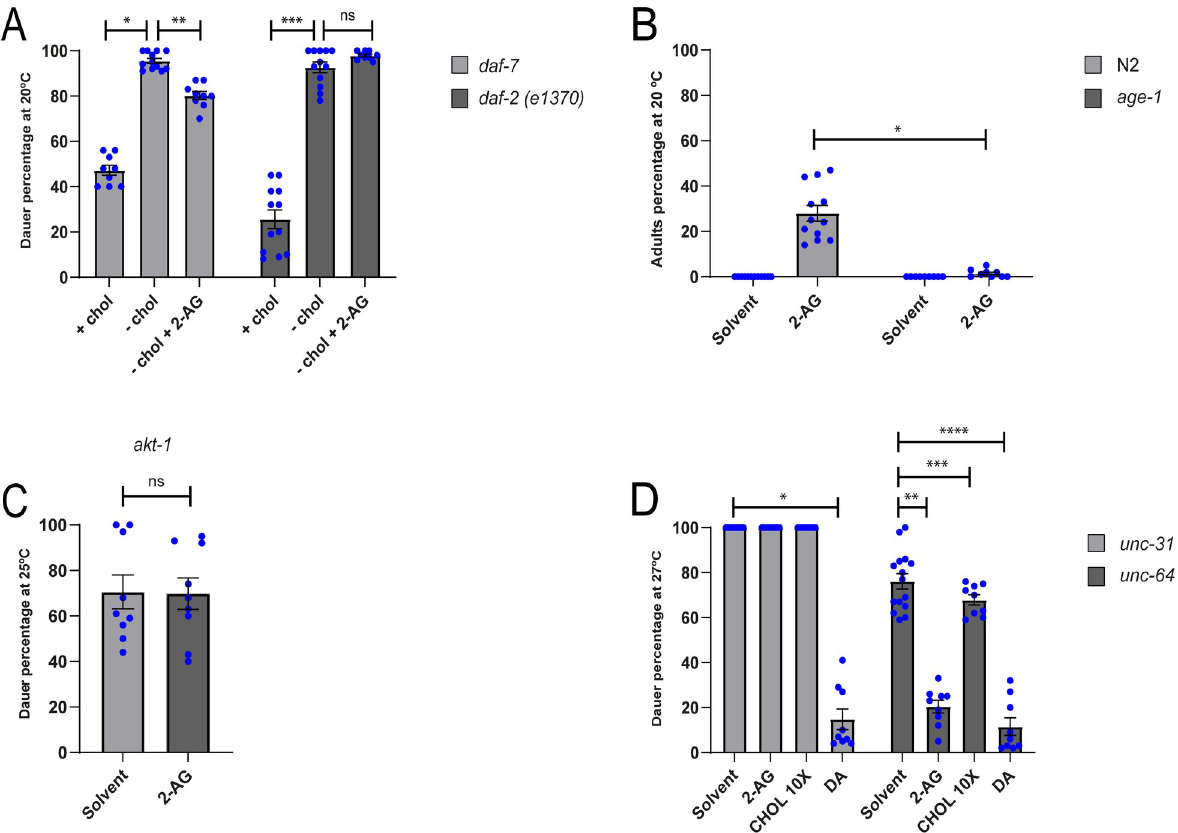
Fig 6. DAF-2 and UNC-31 are required for 2-AG-dependent cholesterol mobilization. (A) daf-7 and daf-2(e1370 ) were grown at 20˚C either in cholesterol or in a sterol-free media during one generation. When indicated the media was supplemented with either 13 μ M cholesterol or 50 μ M 2-AG. All Pairwise are Multiple Comparison Procedures (Dunn’s Method), � p < 0.05. �� p < 0.05. ��� p < 0.05. All values are from n � 3 independent experiments shown as Mean ± SEM. ns = not significant. (B) N2 and age-1 were grown for two generations in media with 0 μ g/ml cholesterol at 20˚C. Mann-Whitney rank sum test, � p < 0.001. All values are from n � 3 independent experiments shown as Mean ± SEM. (C) akt-1 was grown in media with 0 μ g/ml cholesterol during one generation at 25˚C. All values are from n = 3 independent experiments shown as Mean ± SEM. ns = not significant. (D) 2-AG is unable rescue the daf-c phenotype of unc-31 grown at 27˚C. All Pairwise are Multiple Comparison Procedures (Dunn’s Method), � p < 0.05. All Pairwise are Multiple Comparison Procedures (Holm-Sidak method), �� p < 0.05. ��� p < 0.05. ���� p < 0.05. All values are from n � 3 independent experiments shown as Mean ± SEM. N2 is the C . elegans wild-type